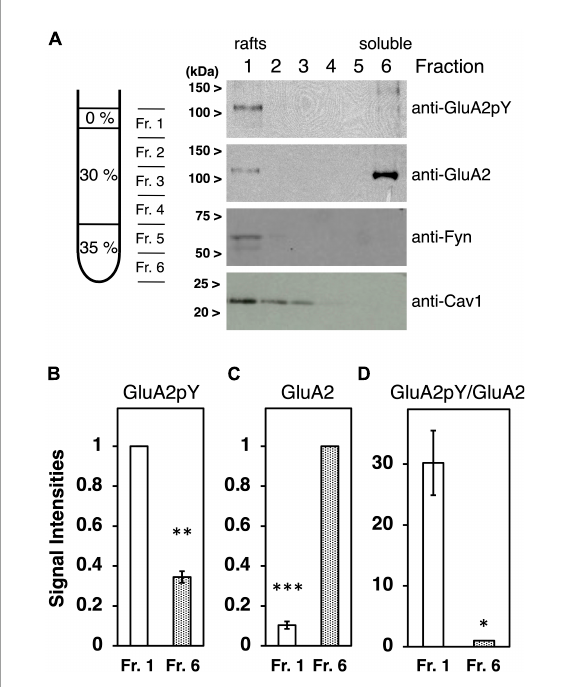
FIGURE1 Characterization of tyrosine phosphorylated GluA2 in lipid rafts fraction. (A) Proteins expressed in cultured cortical neurons were separated by Optiprep-density gradients from the least dense fraction 1 (Fr. 1) to the densest Fr. 6. Representative immunoblots of tyrosine phosphorylated GluA2 (anti-GluA2pY) and GluA2, Fyn, or Caveolin-1 (Cav1) proteins expression are shown. (B) Comparison of tyrosine phosphorylated GluA2 in Fr. 1 (white bar) and Fr. 6 (dotted bar). Band intensities are normalized to Fr. 1 ( n = 3). (C) Comparison of GluA2 protein amount in Fr. 1 (white bar) and Fr. 6 (dotted bar). Band intensities are normalized to Fr. 6 ( n = 3). (D) Ratio of tyrosine phosphorylated GluA2 to GluA2 protein amount in Fr. 1 (white bar) and Fr. 6 (dotted bar). Values are normalized to Fr. 6 ( n = 3). Error bars represent SEM. ∗ p < 0.05, ∗∗ p < 0.01, ∗∗∗ p < 0.001, t